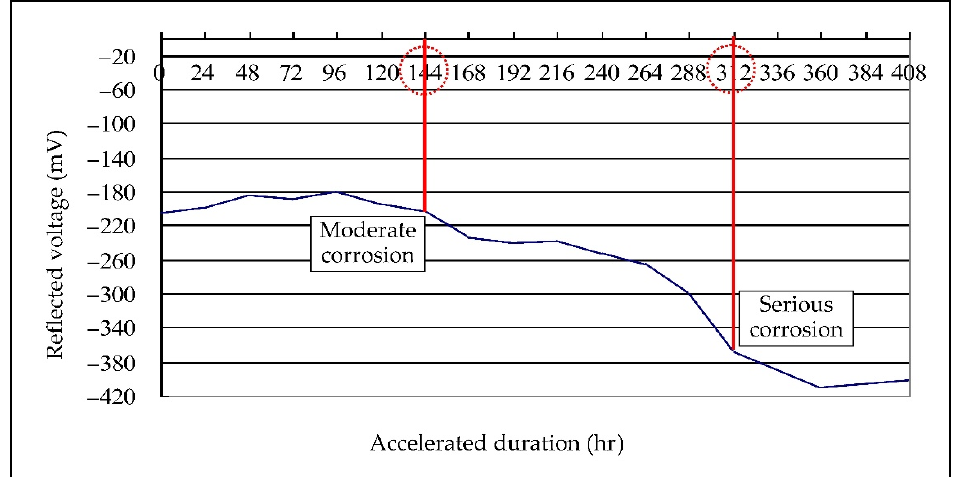
Figure 19. Corrosion Voltage for 7 cm Protective Layer.